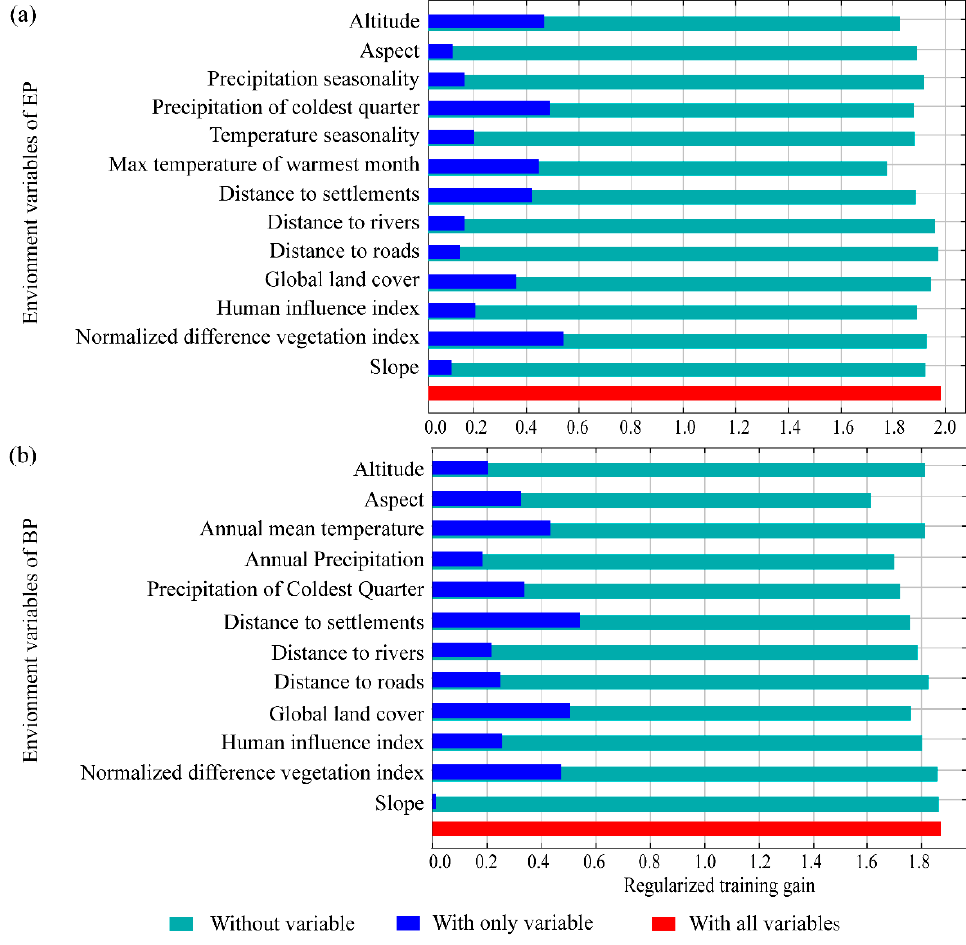
Figure 4. Jackknife test of the importance ranking of environmental variables by the habitat suitability models for ( a ) EP and ( b ) BP. The dark blue band represents the gain to the prediction result when each variable of the model is run separately. The light blue band shows the gain of the model when removing this factor and the model is run only with other variables. The red band at the bottom indicates the gain results when the model uses all variables. The longer the dark blue band, the more important the predictor variable.